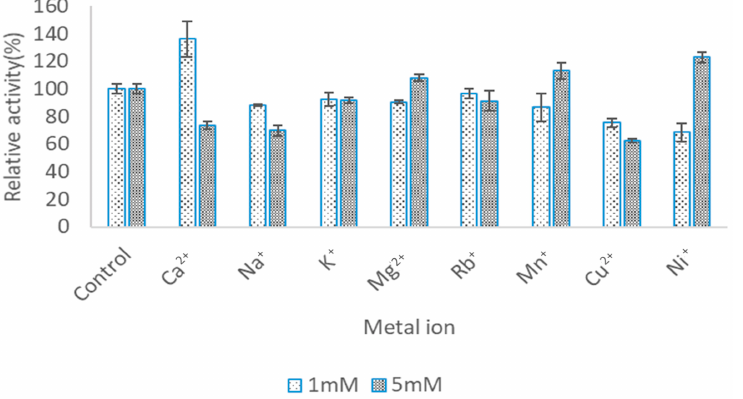
Figure 7. Effect of pH on LIP2 lipase. ( a ) Effect of pH on activity. LIP2 lipase was assayed by using a buffer system with a different range of pH. ( b ) Effect of pH on stability. LIP2 lipase was pre-incubated beforehand using a buffer system with a different range of pH for 30 min. Sodium acetate buffer was used for the pH range of 4.0 to 6.0; potassium phosphate buffer for the pH range of 6.0 to 8.0; Tris-HCL buffer for the pH range of 8.0 to 9.0; glycine-NaOH buffer for the pH range of 9.0 to 11: and Na 2 HPO 3 /NaOH for the pH range of 11.0 to 12.0. The relative activity was calculated based on the percentage of the highest activity. The error bars indicate standard deviation of means ( n = 3). The absence of a bar indicates that errors were smaller than the symbols and the line.